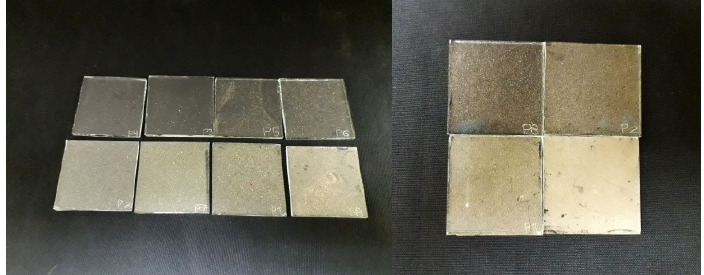
Figure 9. Detail of some artificially soiled pollen samples.